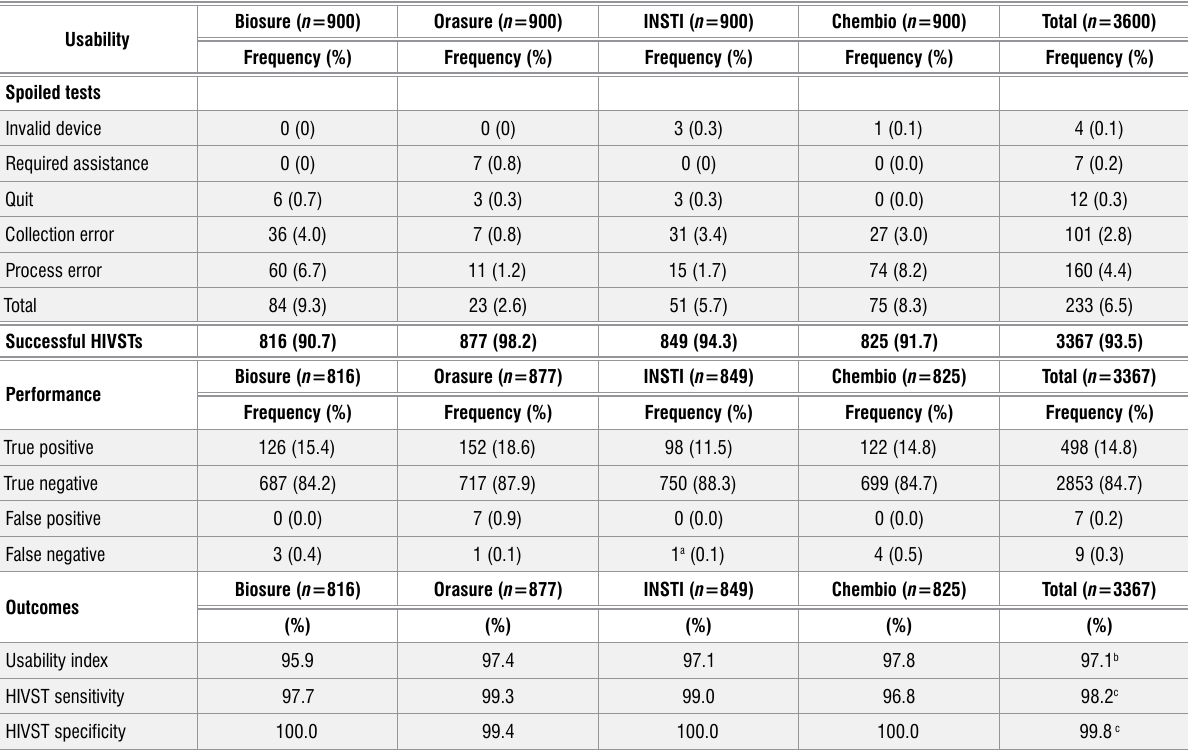
HIV self-testing (HIVST) usability and performance